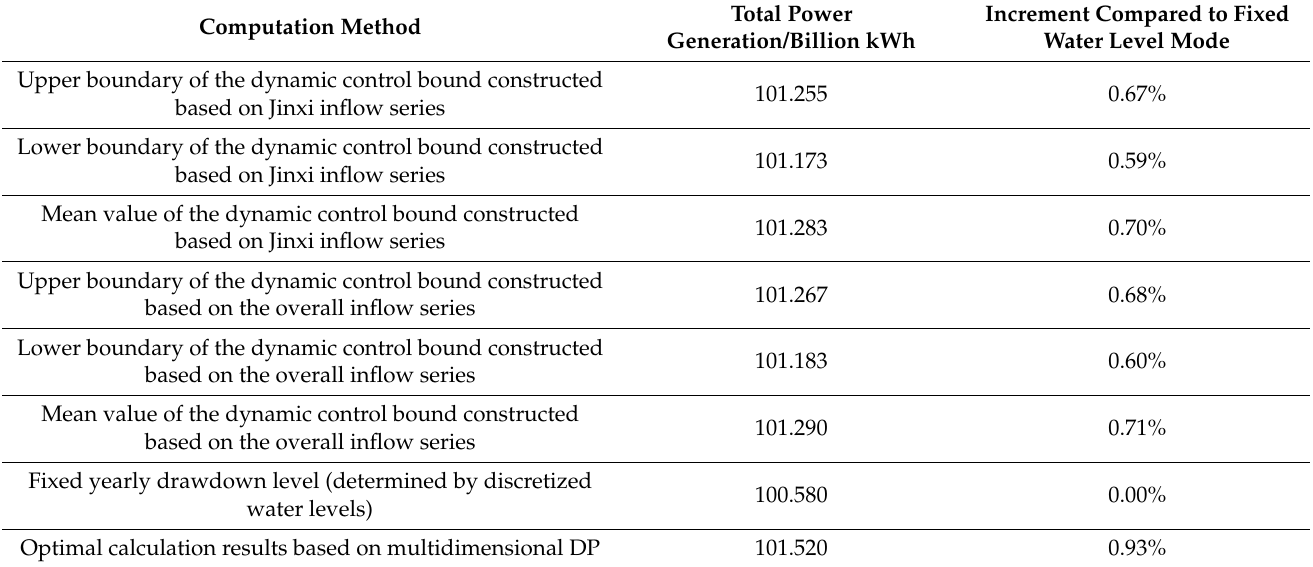
Table 3. Power generation results under the three control modes based on the obtained dynamic control